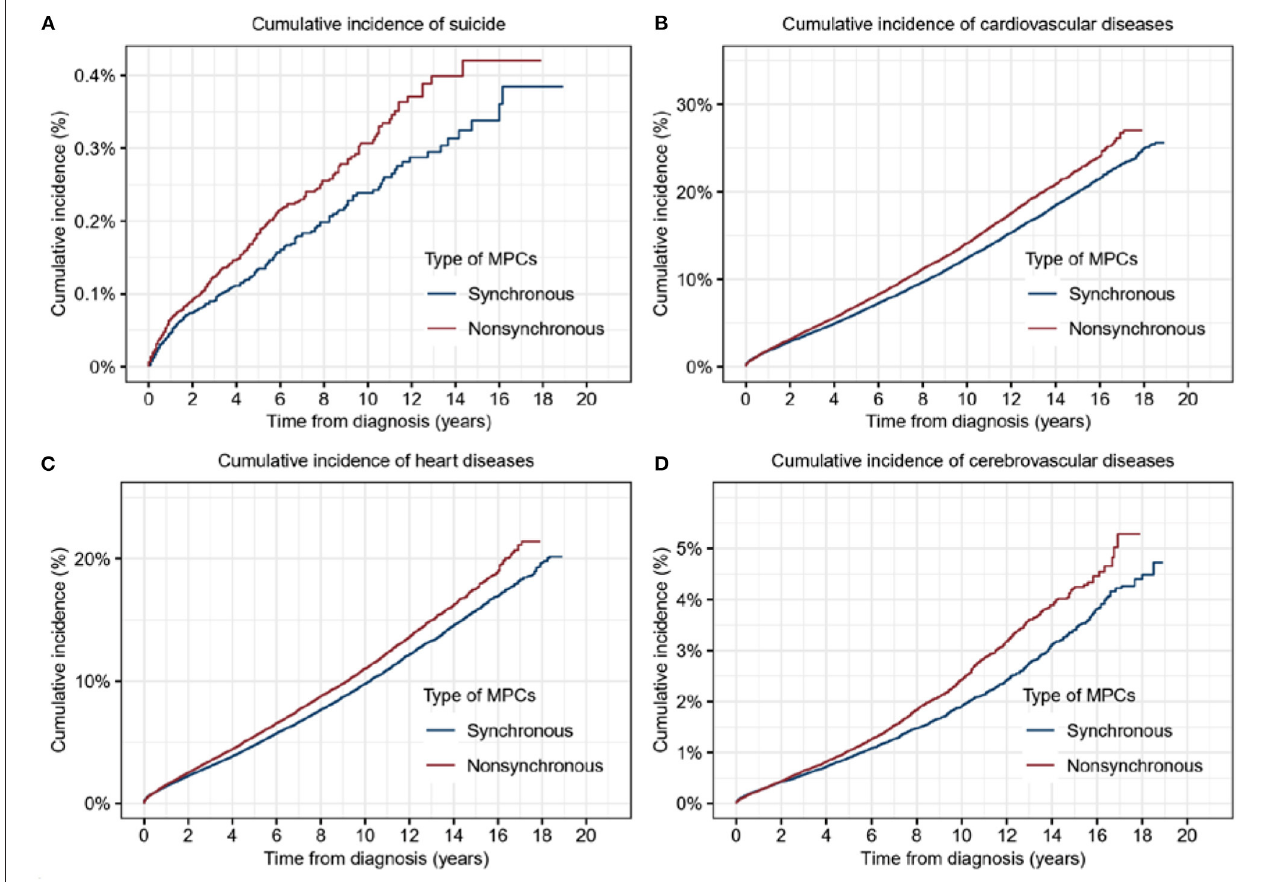
FIGURE 3 | Cumulative incidence of suicide and cardiovascular diseases for patients with synchronous multiple primary cancers (MPCs) or asynchronous MPCs. (A) Cumulative incidence of suicide for patients with synchronous MPCs or asynchronous MPCs. (B) Cumulative incidence of cardiovascular diseases for patients with synchronous MPCs or asynchronous MPCs. (C) Cumulative incidence of heart diseases for patients with synchronous MPCs or asynchronous MPCs. (D) Cumulative incidence of cerebrovascular diseases for patients with synchronous MPCs or asynchronous